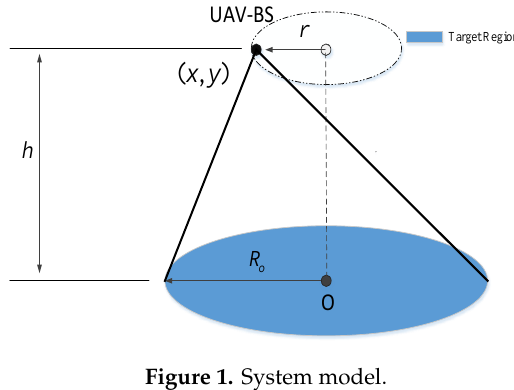
Figure 1. System Figure 1. System model.